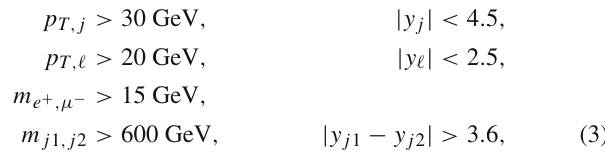
in the final-state are neglected. These terms are both phase- space and colour suppressed. When imposing VBF-specific cuts, their contribution to the cross section becomes negli- gible. Some example Feynman diagrams of the LO process are depicted in Fig. 1. They show the rich structure of this process, which includes contributions from quartic gauge- boson vertices (top left diagram), triple gauge-boson vertices (top right), and Higgs-mediated exchange (bottom left). An example of a non-resonant contribution is shown in the bot- tom right diagram of Fig. 1. The NLO QCD corrections to this process have been first presented in Ref.